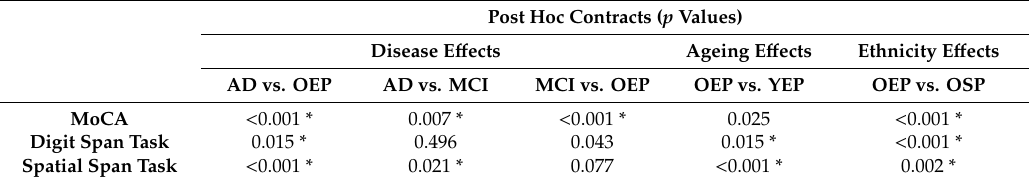
Table 2. Table displaying post hoc comparisons for the neurological